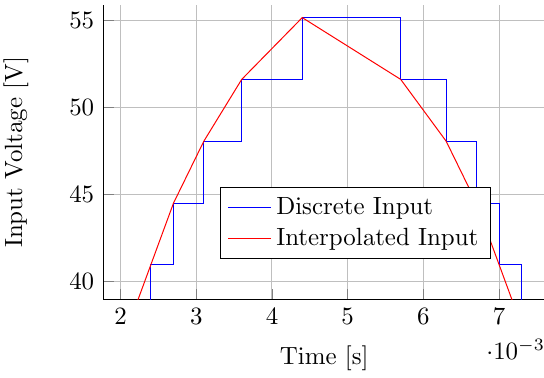
Figure 9: Illustration of the proposed linear interpola- tion applied in the inverse